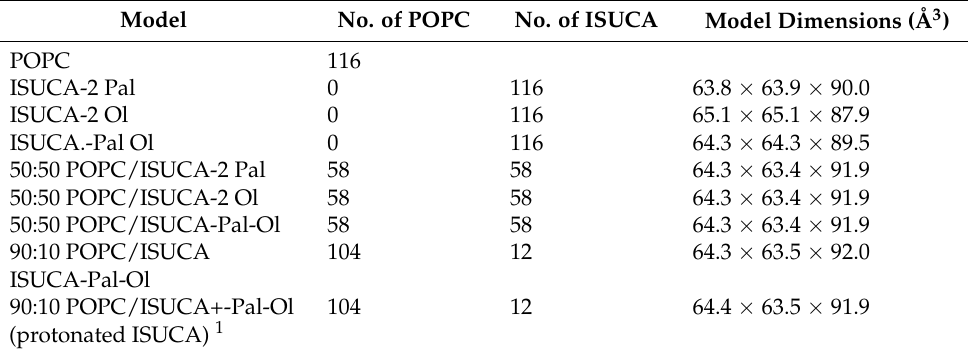
Table 4. Number of beads and cell dimensions of the bilayers studied by CGMD. Model